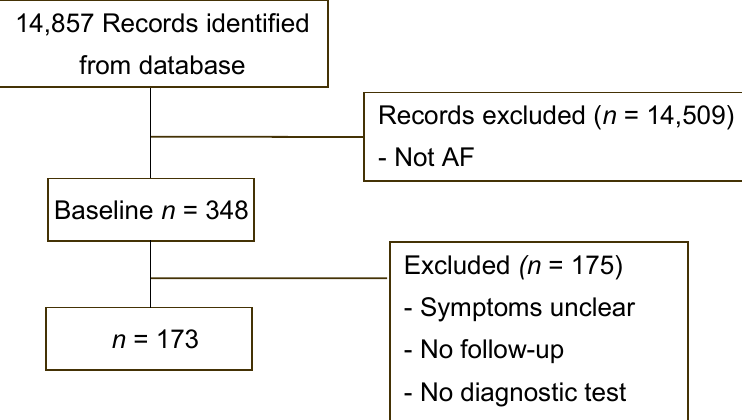
Figure 1. Inclusion and exclusion criteria for patients with AF. AF: amaurosis fugax